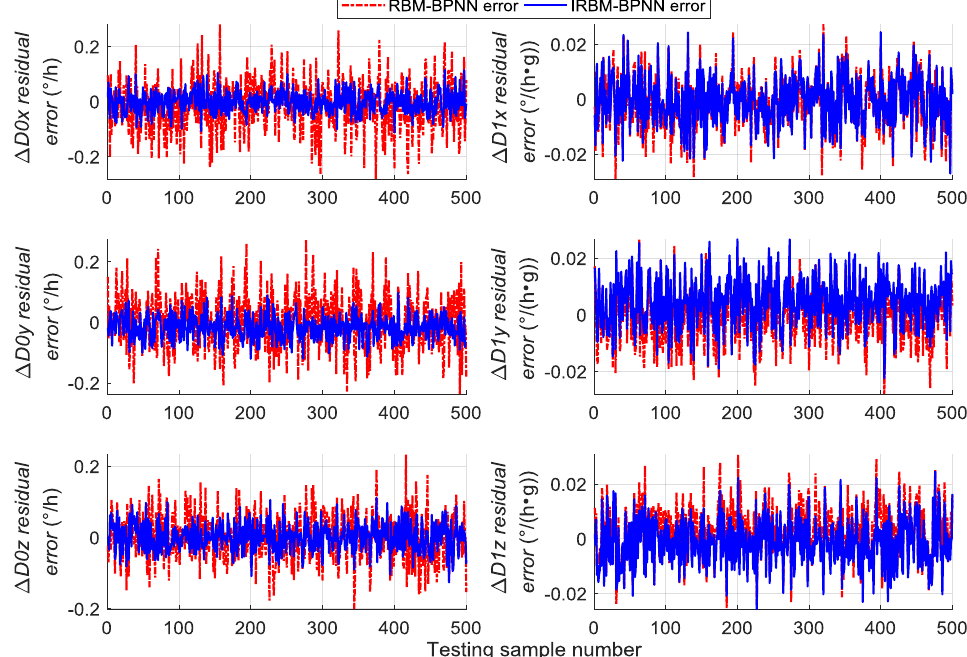
Figure 11. Contrast results of gyroscope residual error using RBM-BPNN and IRBM-BPNN method.